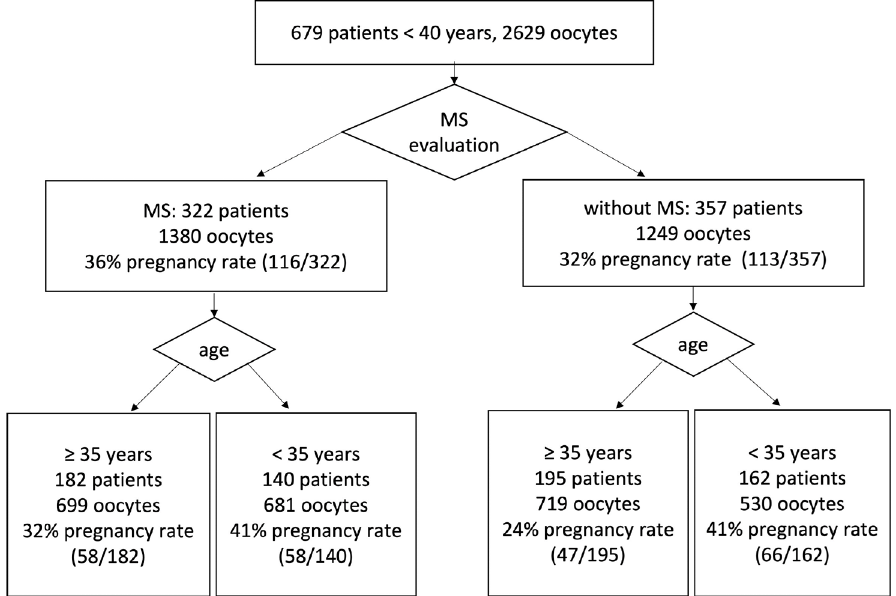
Figure 2. A total of 679 patients with planned ICSI fertilization were divided into two groups. In one group patients had time of ICSI determined on the basis of the relative position of PB and MS visibility. The second group was treated without MS evaluation. We compared the probability of clinical pregnancy for patients with the time of ICSI determined on the basis of the relative position of PB and MS and MS visibility with the probability of clinical pregnancy for patients without MS evaluation.